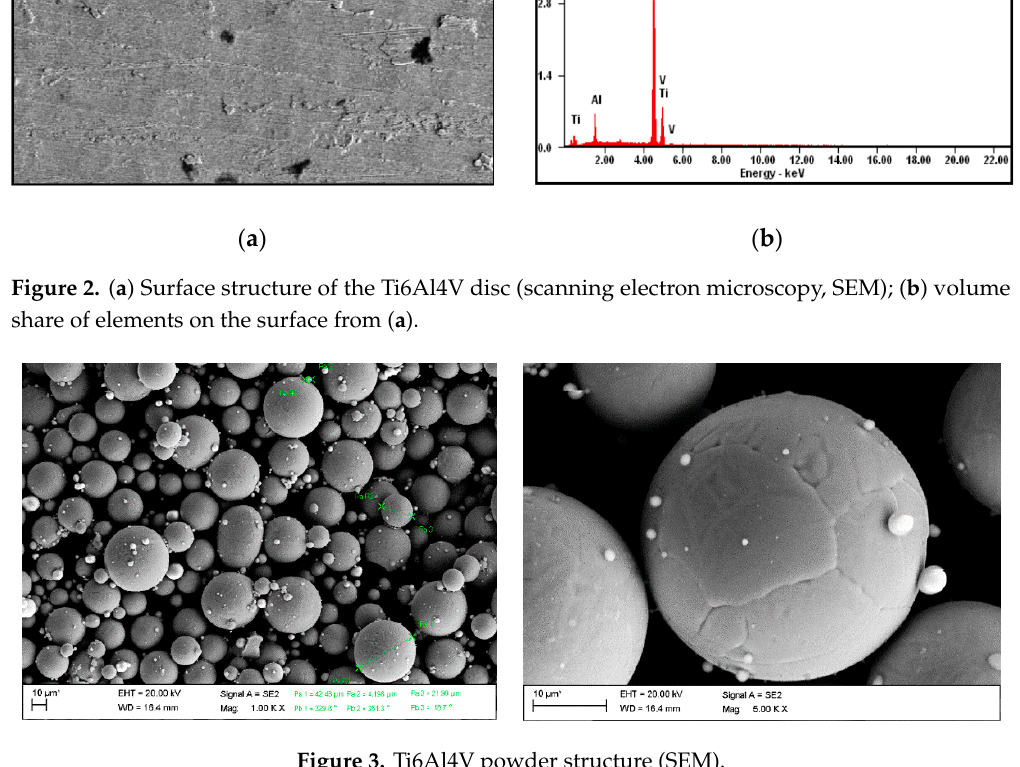
Figure 3. Ti6Al4V powder structure (SEM).